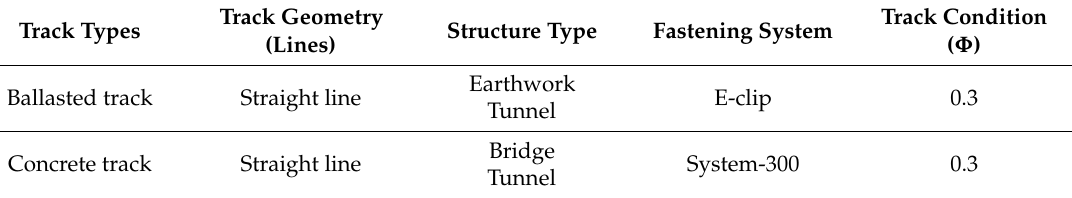
Table 4. Types of track evaluated.